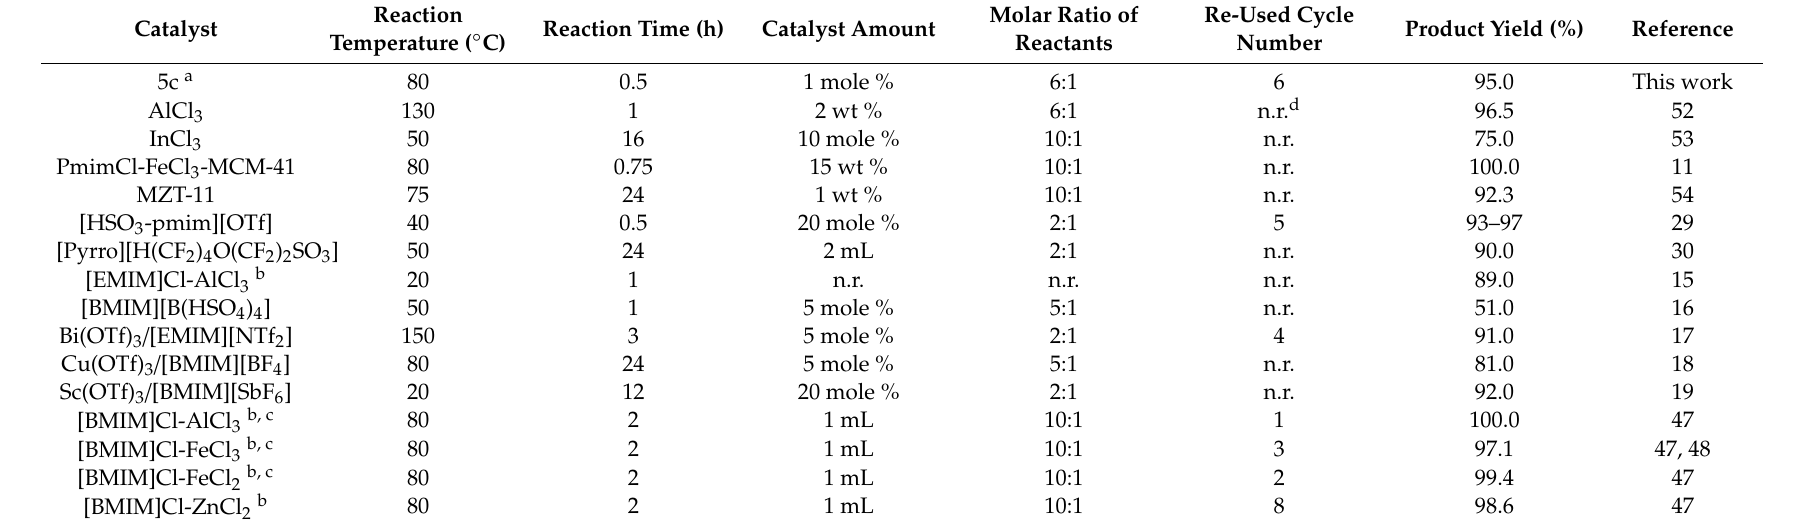
Table 2. Comparison of reaction conditions between B-L MIL 5c and previously reported